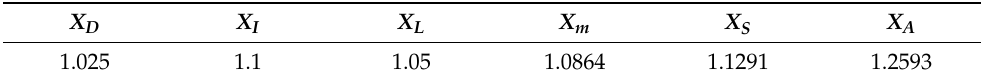
Table 5. Optimized results of aircraft parameters.